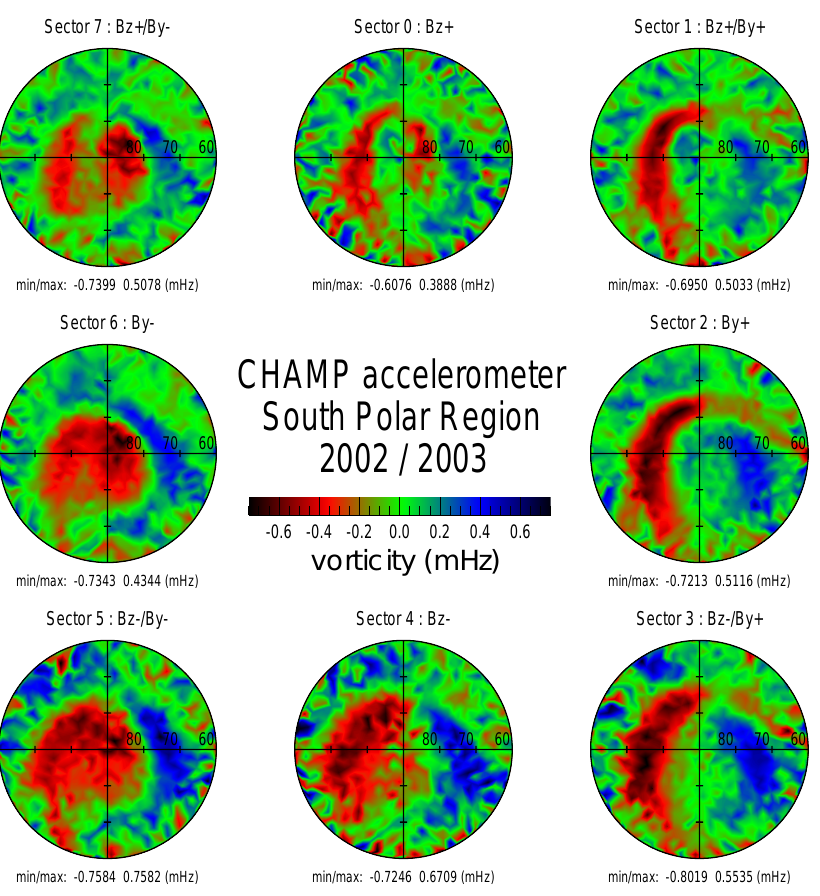
Fig. 3. Average thermospheric vorticity patterns, sorted for 8 distinct sectors of IMF orientation. Each sector comprises 45 ◦ of IMF clock angle range centered around the direction indicated on top of each panel. The data are for the same time interval, presented in the same magnetic latitude/MLT coordinates and colour scale as in Fig. 1, bottom panel. Minimum and maximum values for the latitude range > 70 ◦ are indicated below each